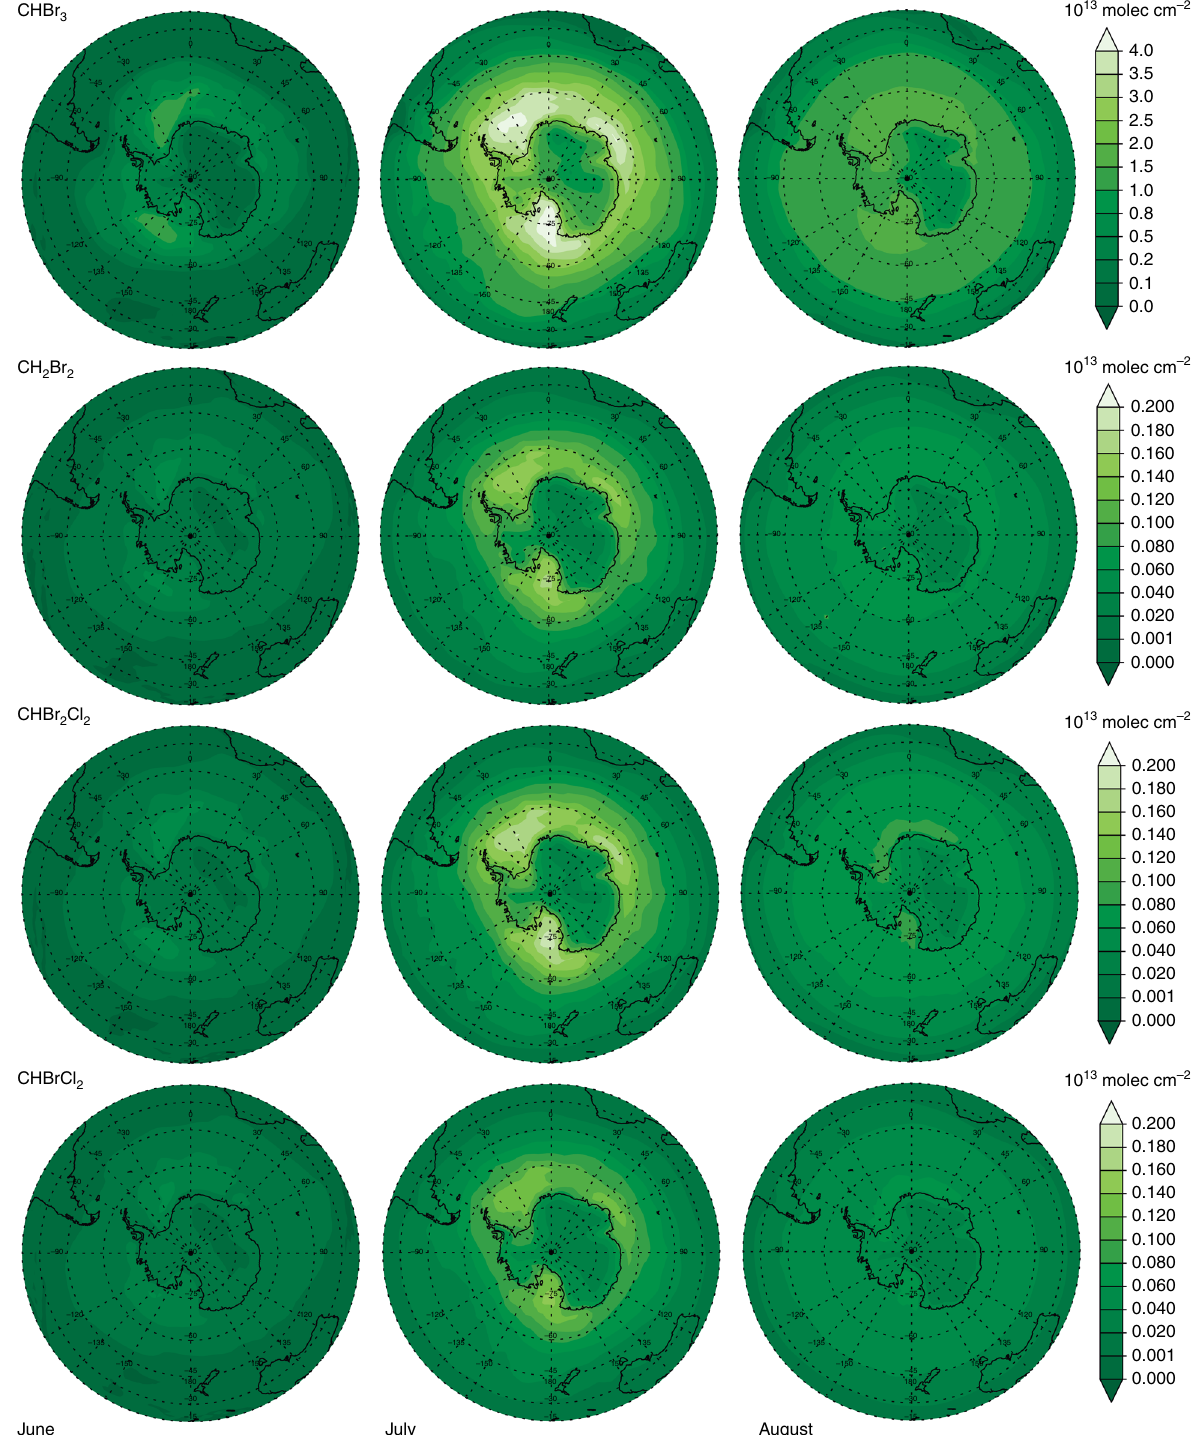
Fig. 4 Modeled distribution of monthly averaged tropospheric (CHBr 3 , CH 2 Br 2 , CHBr 2 Cl, and CHBrCl 2 ) over the Southern Hemisphere. This spatial distribution is the result of sea ice emissions of bromocarbons during the Antarctic winter using the averaged fl uxes of bromocarbons from Table 1 ( fl ux